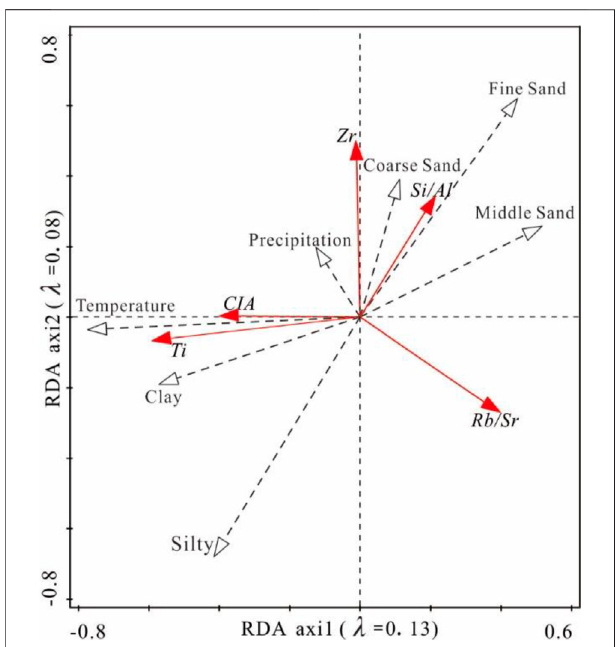
FIGURE 5 | RDA plot of environmental indices and